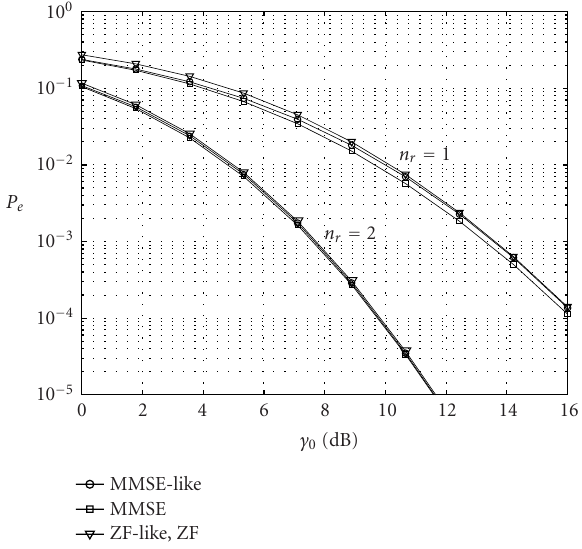
Figure 6: Probability of error for the nonblind receivers: MMSE- like, MMSE, ZF-like, and ZF: K = 4, M = 8, N = 4, and n t = 2 .